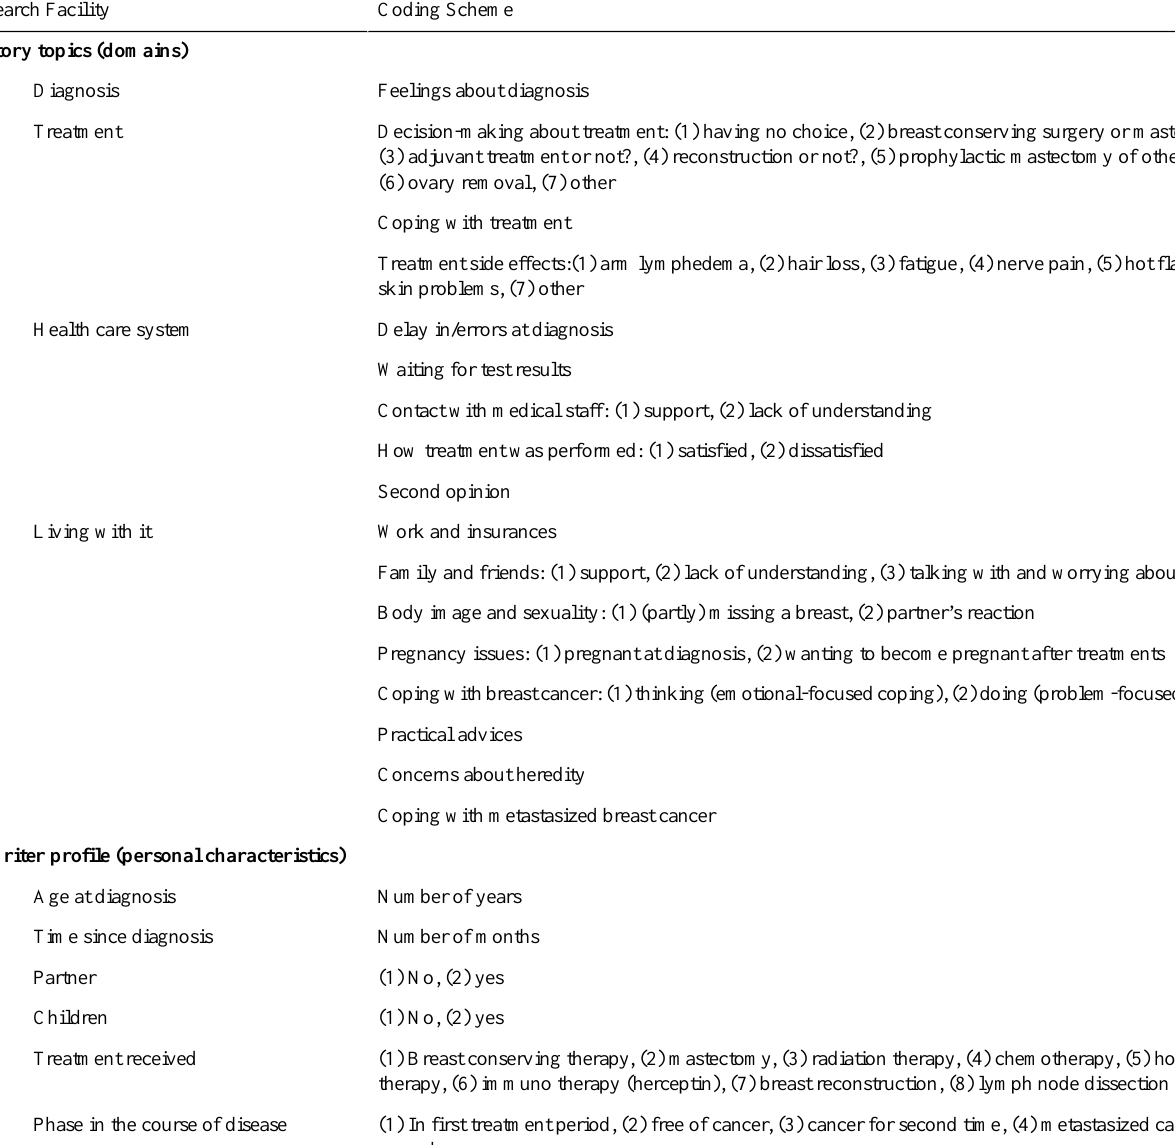
Coding SchemeSearch